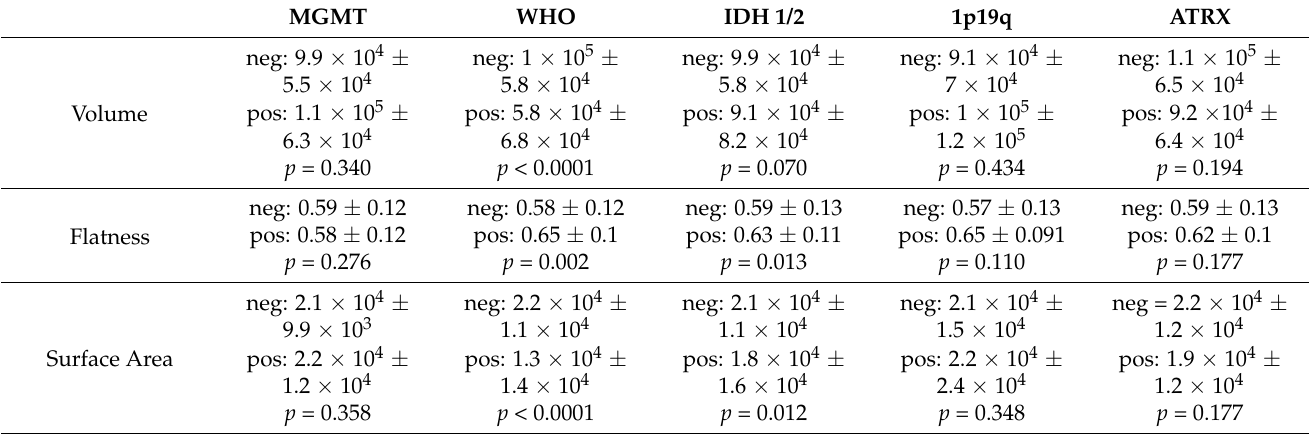
Table 4. Lesion-specific features for positive and negative samples and the Bonferroni corrected Mann-Whitney U statistics grouped by label.